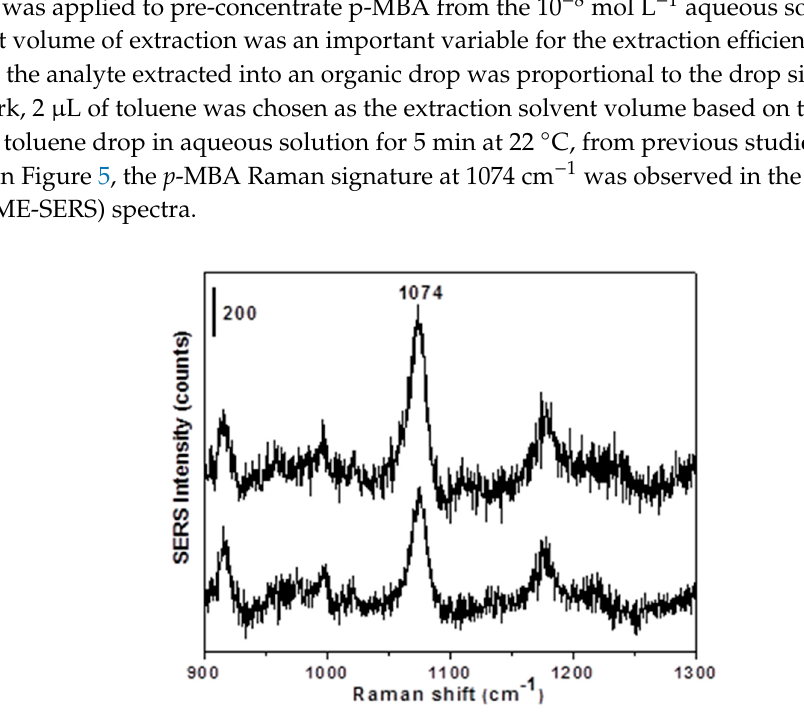
Figure 5. SERS spectra of p -MBA after SDME microextraction from a 10 − 8 mol L − 1 solution. The SERS intensity scale bar is 200 counts. Laser wavelength: 633 nm; laser power: 2.5 mW.